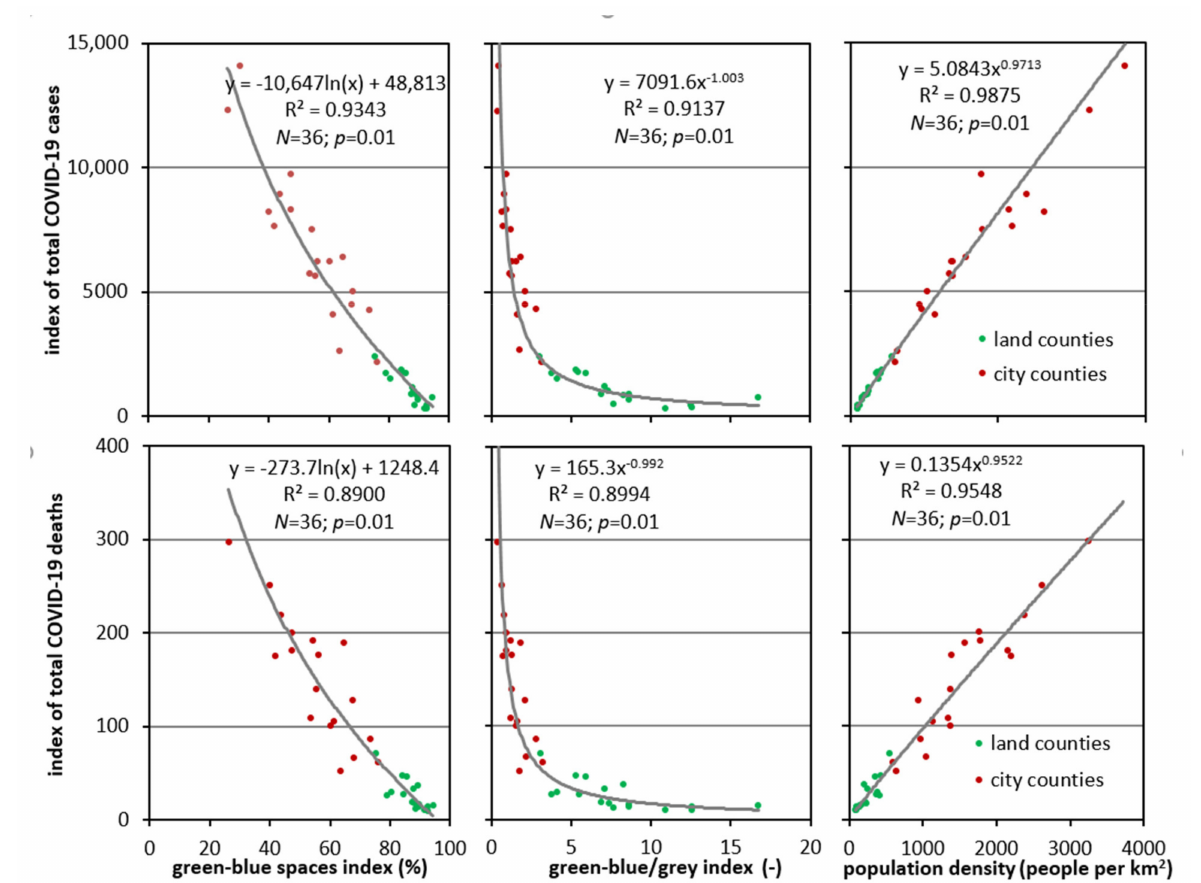
Figure 8. Relationships between the green-blue spaces index (%), green-blue/grey index ( − ), and population density (people per 1 km 2 ) and the indices of: the total number of COVID-19 cases (people per 100 km 2 ) and the total number of COVID-19 deaths (people per 100 km 2 ) in Silesia